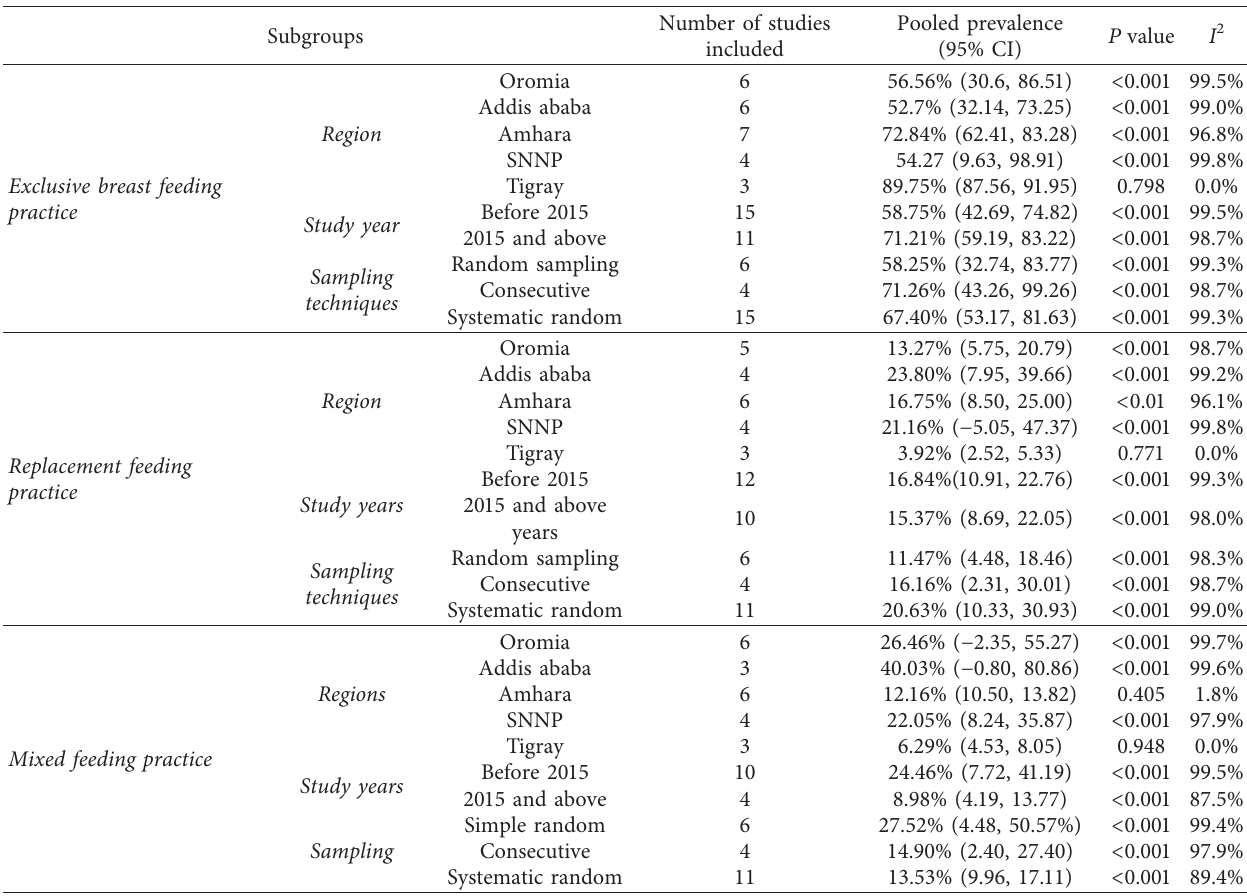
Table 2: Subgroup analysis which describes pooled prevalence of infant feeding practice among HIV-exposed infants in Ethiopia.